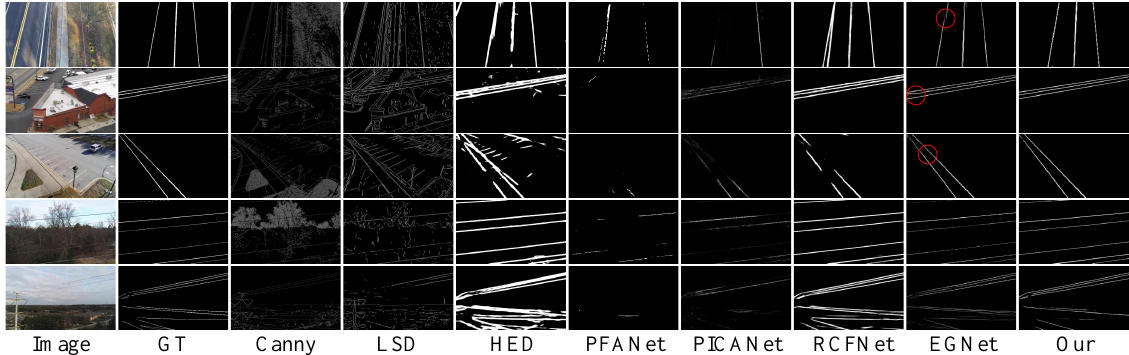
Figure 9. Comparison of power line detection results on the TTPLA dataset.